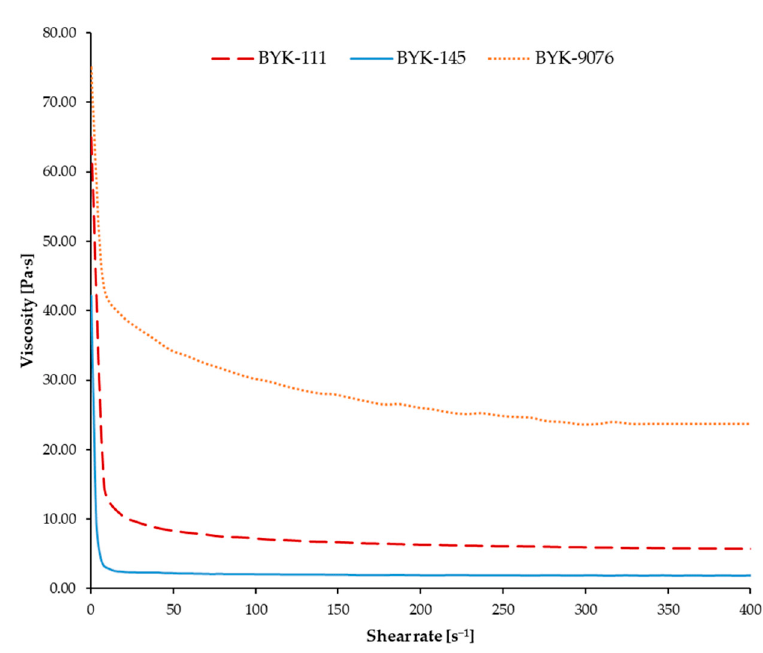
Figure 5. Viscosity vs. shear rate of slurries with different dispersants. After choosing the optimal dispersant, its weight percentage content was varied to understand the different outcomes in terms of viscosity and to comprehend if there was a saturation value beyond which the dispersant is actually agglomerating rather than dispersing. Viscosity tests were then carried out, and the results are plotted in Figure 6.